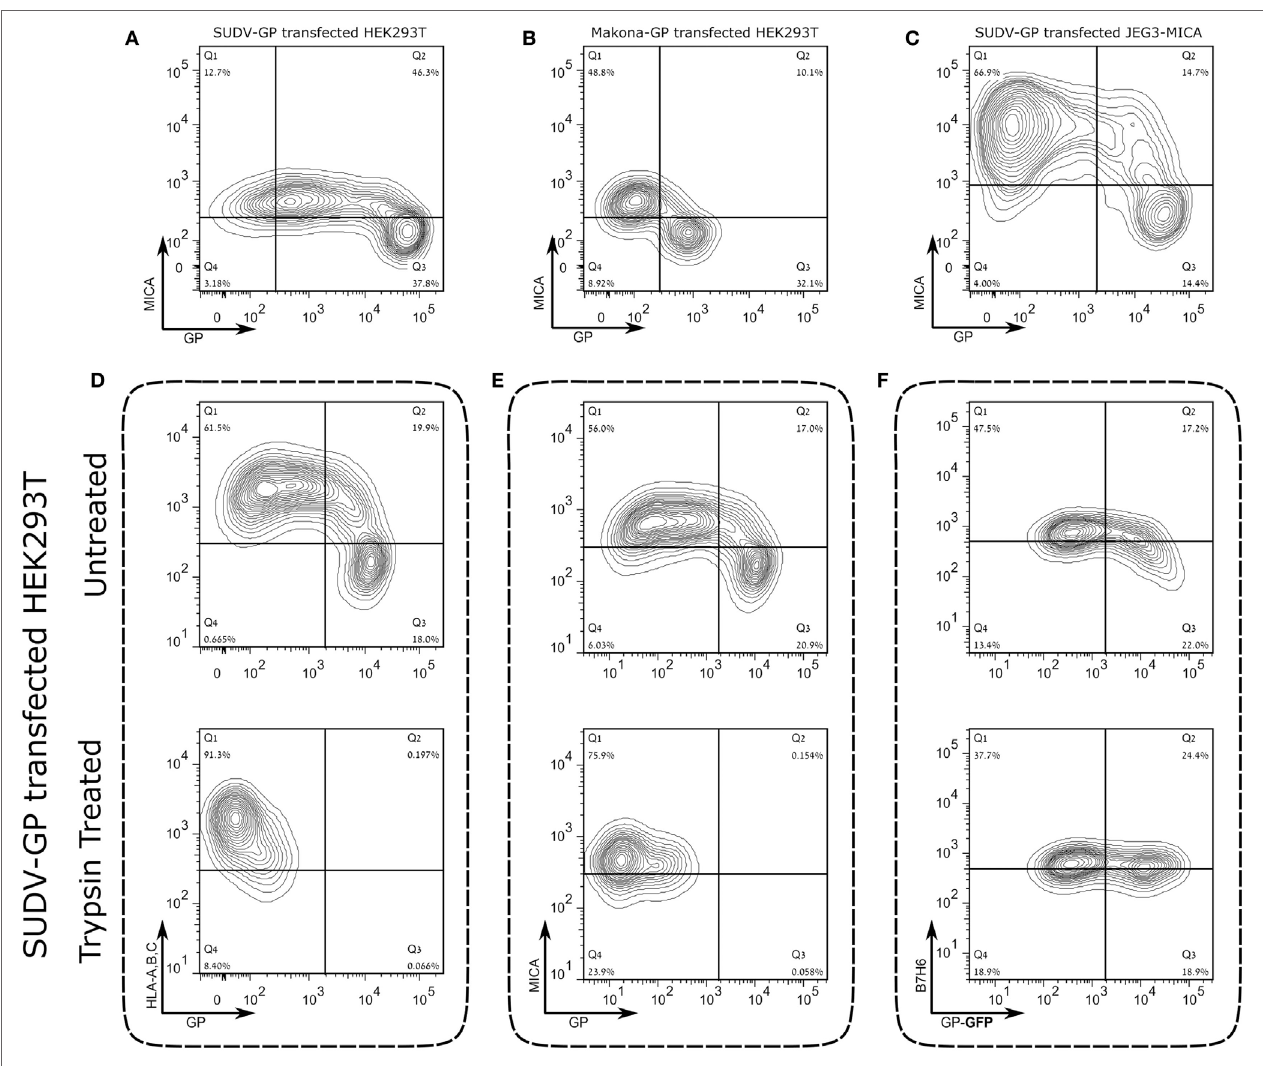
FigUre 4 | Expression of the Sudan virus (SUDV)- or Makona-GP results in loss of surface staining of α MICA in HEK293T cells and JEG3 cells stably transfected with MICA. The figure shows representative flow cytometry analysis for steric shielding of the MICA antigen by SUDV-GP or Makona-GP. (a) HEK293T cells were transfected, harvested, and stained for SUDV-GP with a biotinylated 3C10 antibody, followed by allophycocyanin (APC)-conjugated streptavidin, and co-stained for MICA surface antigens with phycoerythrin (PE)-conjugated α MICA antibody. Results are from one representative experiment of more than 10 performed (B) HEK293T cells were transfected, harvested, and stained for Makona-GP with survivor sera, followed by APC-labeled secondary antibody, and co-stained for MICA surface antigen using PE-conjugated α MICA antibody. Results are from one representative experiment of two performed. (c) SUDV-GP-transfected JEG3-MICA cells stained for SUDV-GP and co-stained for MICA surface antigens and NKG2D-Ig ligands. Results are from one representative experiment of more than four performed. (D–F) HEK293T cells were transfected with SUDV-GP or SUDV-GP-GFP, harvested shortly after they were treated with trypsin or left untreated, and finally stained for: (D) HLA-A, B, C, and SUDV-GP, (e) MICA and SUDV-GP, and (F) B7H6. Results are from one representative experiment of more than four